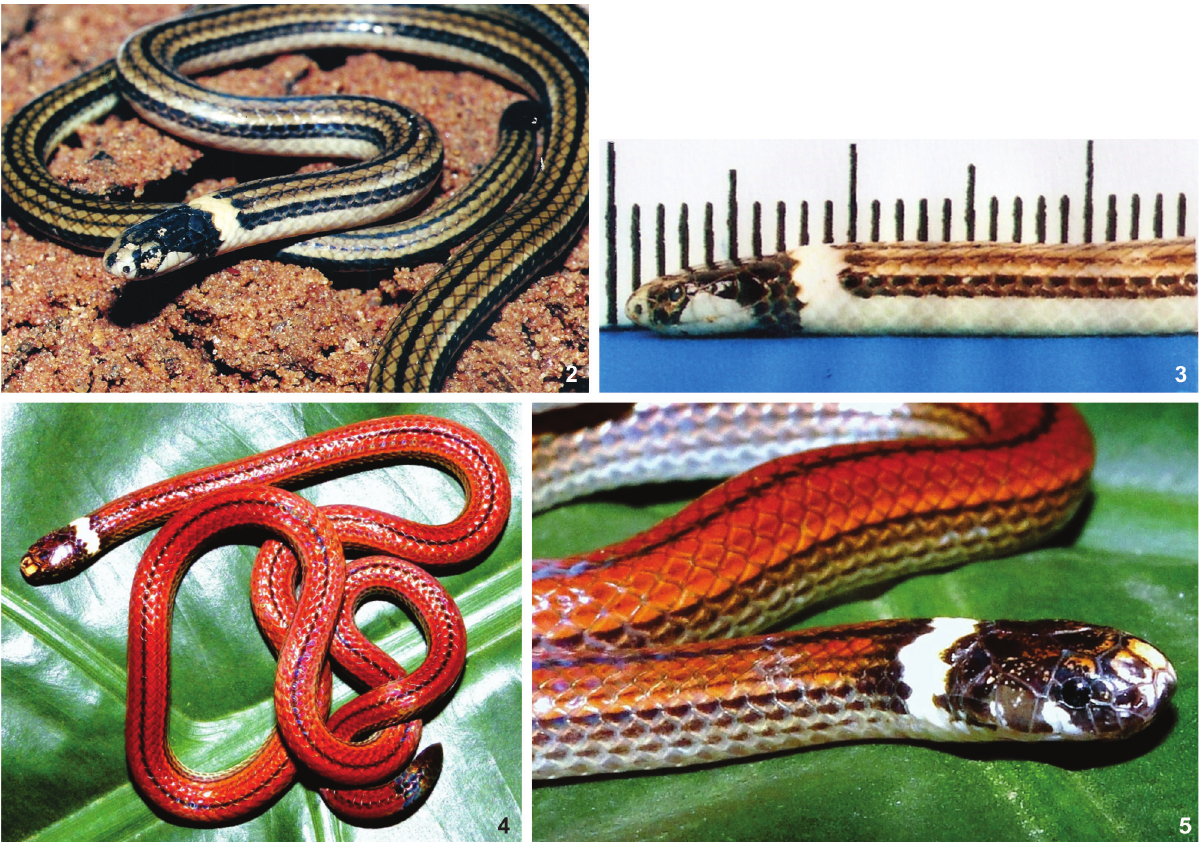
Figure 2–5. (2) Holotype of Apostolepis kikoi sp. nov. (MCP 12096) from the reservoir of Manso hydroelectrical power plant, Chapada dos Guimarães, Mato Grosso, Brazil (photo by Marcos Di Bernardo). (3) Lateral view of holotype (preserved) of Apostolepis kikoi sp. nov. (MCP 12096) from the reservoir of Manso hydroelectrical power plant, Chapada dos Guimarães, Mato Grosso, Brazil (photo by Marcos Di Bernardo). Dorsal (4) and lateral (5) views of the specimen of Apostolepis nigroterminata (UFAC 504) from Campus Universitário